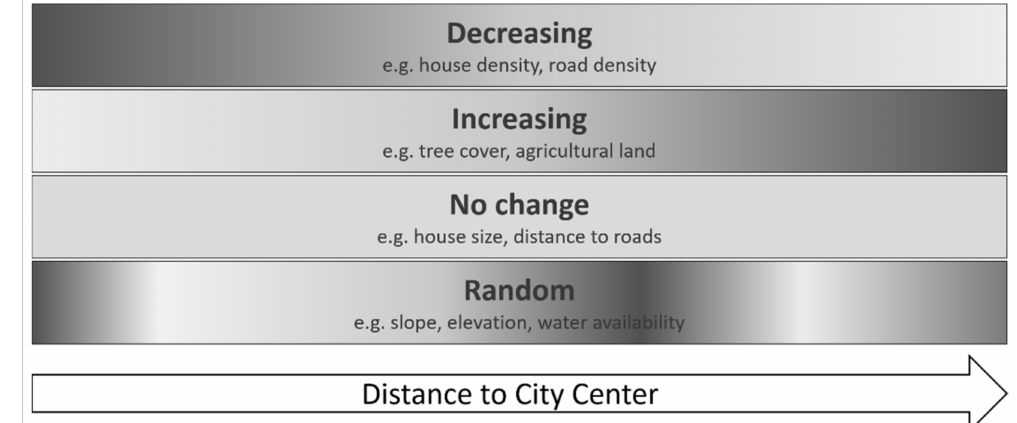
Figure 8. Spatial dynamics of characteristics on a perio-urban